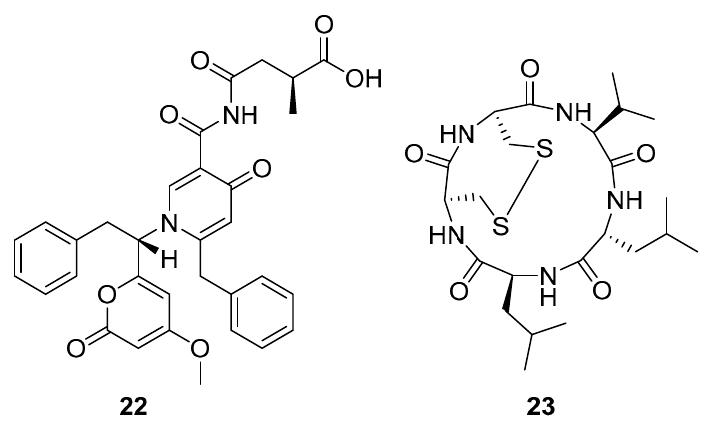
Figure 9. Structures of aspernigrin C ( 22 ) and malformin C ( 23 ).